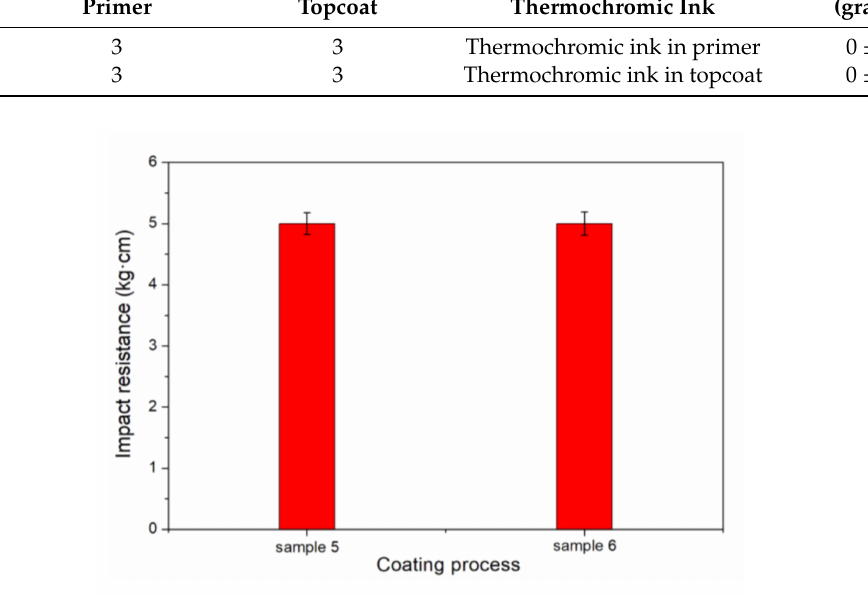
Figure 9. The impact resistance of waterborne coating on Chinese fir (samples 5–6 from Table